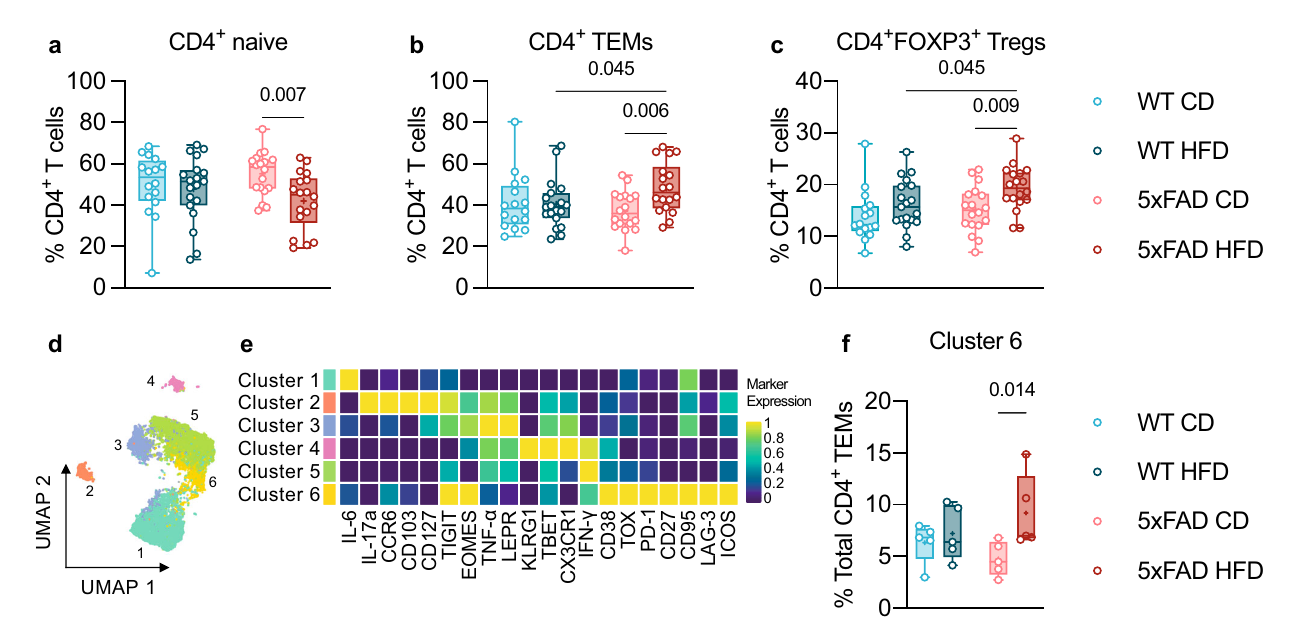
Fig. 3 | Splenic CD4 + T-cell rearrangements in HFD-fed 5xFAD mice. a – c CD4 + T-cellimmunedeviationsinHFD-fed5xFADmice.Flowcytometricquanti fi cationof splenic frequencies of CD4 + naive T cells (CD44 low CD62L high ; a ), CD4 + TEMs (CD44 high CD62L low ; b ), and CD4 + FOXP3 + Tregs ( c ). Mice from two independent experiments, sample n : WT CD=16, WT HFD=19, 5xFAD CD=18, 5xFAD HFD=18. Statistical analyses: two-way ANOVA followed by Fisher ’ s LSD post hoc test. d – f Characterization of the CD4 + TEM compartment by mass cytometry. Cryo- preserved splenocytes from mice evaluated for both cognition (NOR test; Fig. 1c) and systemic immune phenotype (Fig. 3a – c) were used for CyTOF analysis of the CD4 + TEM compartment, sample n : WT CD=5, WT HFD=5, 5xFAD CD=5, 5xFAD